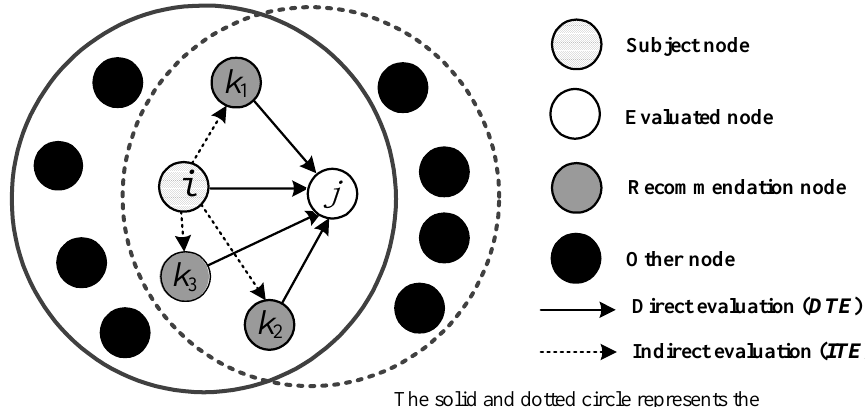
Figure 2. The recommendation trust relationship among